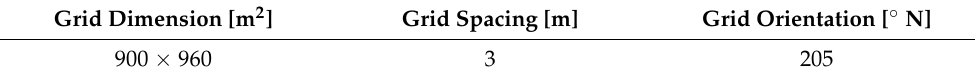
Table 3. Grid geometric